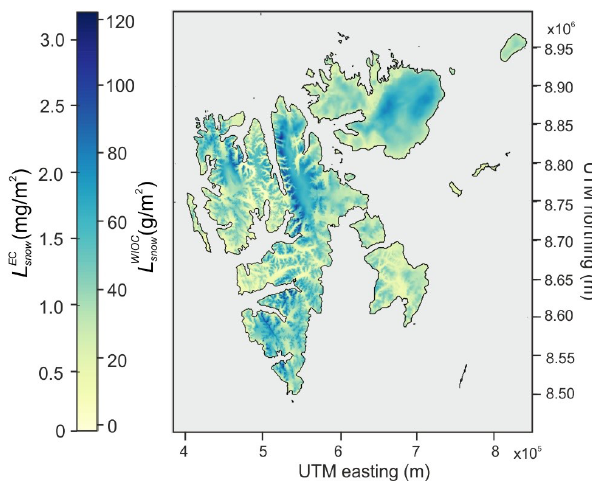
Figure 7. Map of the estimated L EC snow and L WIOC snow in the late win- ter 2015–2016 snowpack over Svalbard, based on the empirical re- lationships shown in Fig. 6, applied to the map of h SWE